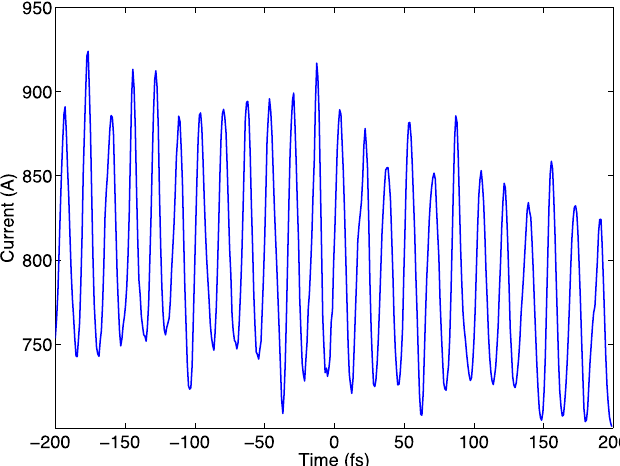
Figure 4. Current oscillations for the case of the dashed energy profile from Figure 2, after the e-beam passes through the strong dispersive